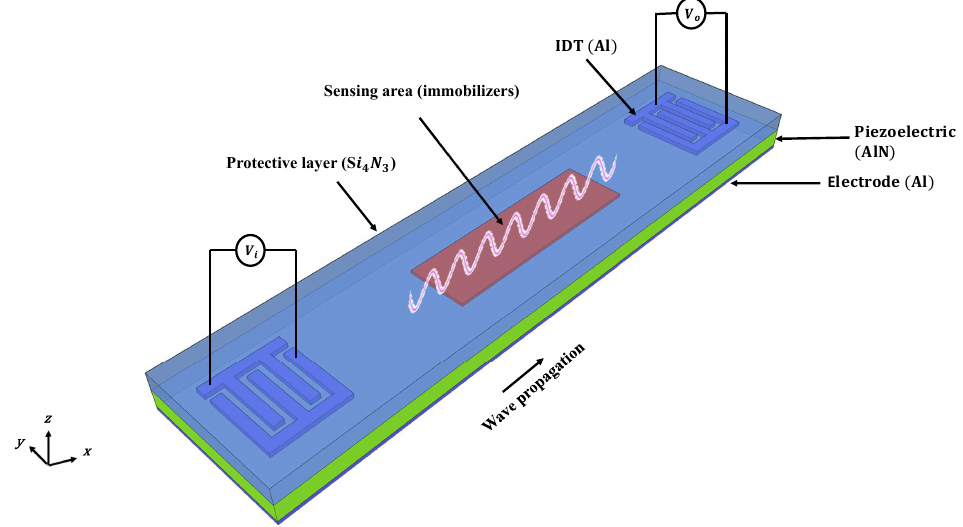
Figure 2. Three-dimensional schematic of the device showing different layer order, IDT locations, and the wave propagation